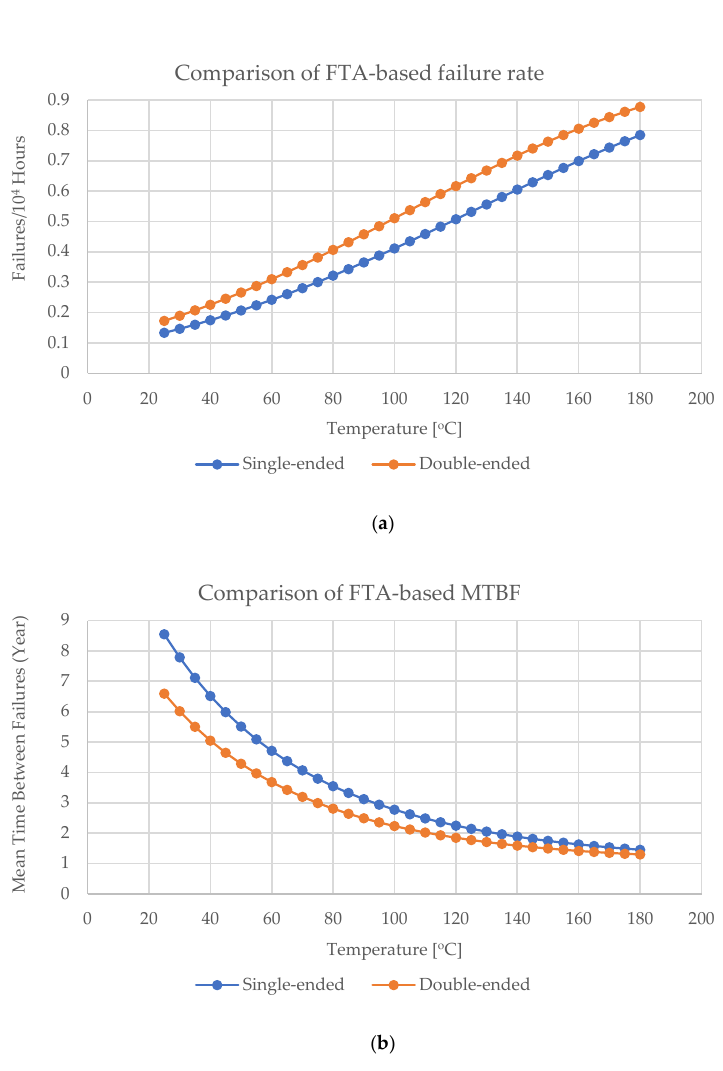
Figure 6. FTA-based comparison of the single-ended and double-ended forward converter: ( a ) failure rate; ( b ) mean time between failures (MTBF).